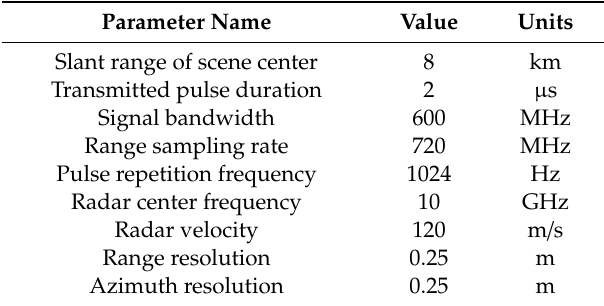
Table 3. System parameters for surface target simulation.